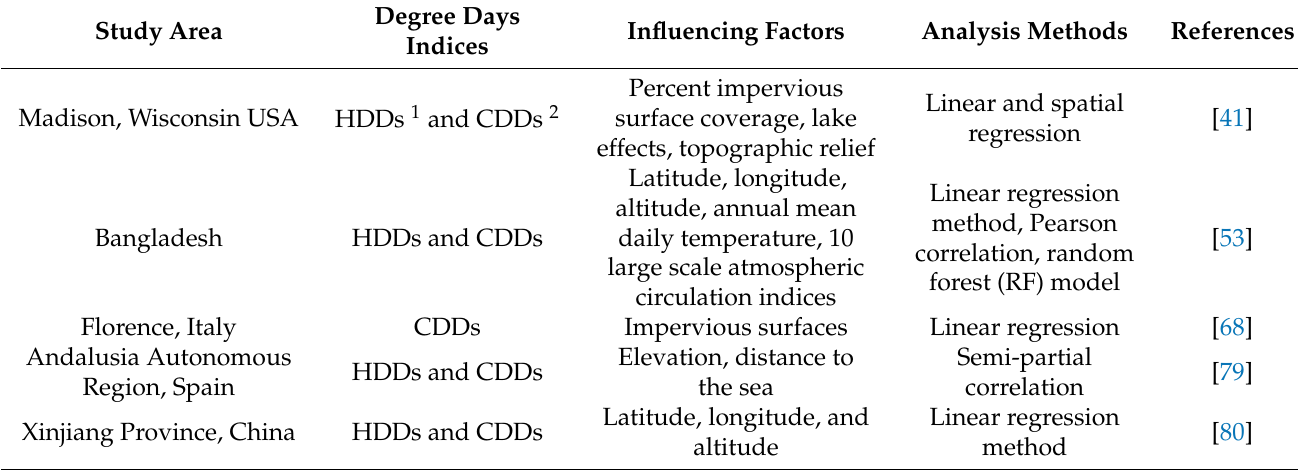
Table 3. Studies on influencing factors of heating and cooling degree days.